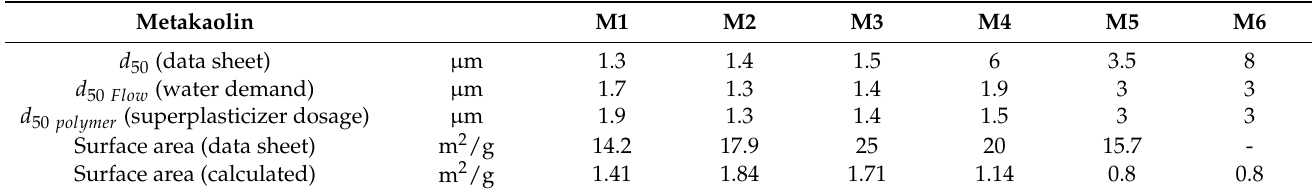
Figure 4. ( a ) Water demand as a function of metakaolin substitution and thus for the six different metakaolins. ( b ) Water demand as a function of surface area calculated for the two binders. The surface area of cement is taken as 0.4 m 2 /g, whereas those of metakaolin are obtained from the shifts to obtain the master curves. Values of the surface areas obtained from the shifts are given in Table 9. Table 9. Comparison of the mean size diameters from the data sheet and those obtained from measurements of water demand (Figure 4) and superplasticizer dosage. The surface areas are either taken from the product data sheet (data sheet) or obtained from the water demand shift (calculated). The d 50 Flow (water demand) is calculated from the surface area using Equation (1). The d 50 polymer is obtained from the surface area calculated with Equation (1).